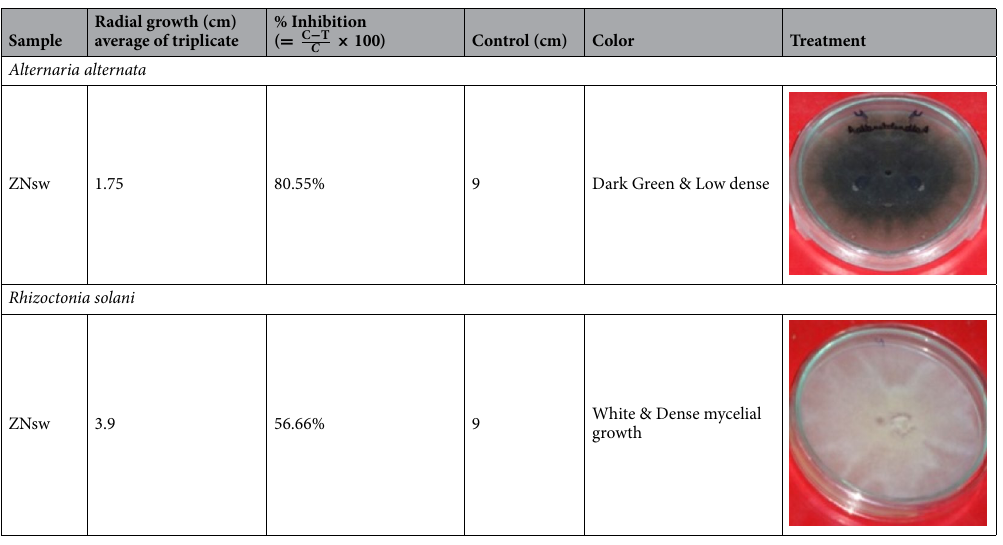
Table 1. Antifungal activity of ZnO Nano-swirlings at different stirring conditions (after 6 days of Inoculation). ZNsw ZnO Nano-swirlings; C Diameter of control colony; T Diameter of treated